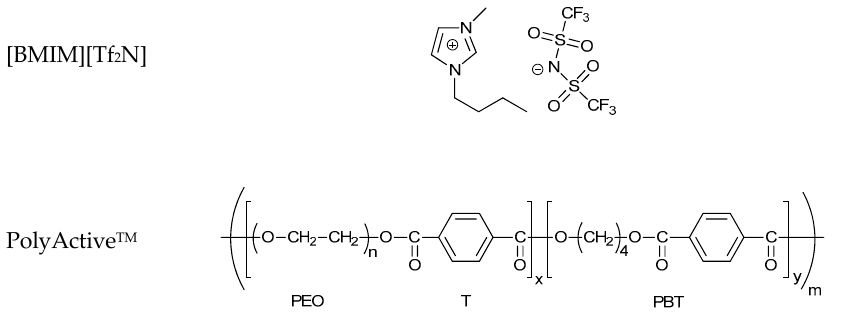
Figure 1. Molecular structure of 1-butyl-3-methylimidazolium bis(trifluoromethylsulfonyl)imide [BMIM][Tf 2 N] and generalized structure of PolyActive TM .